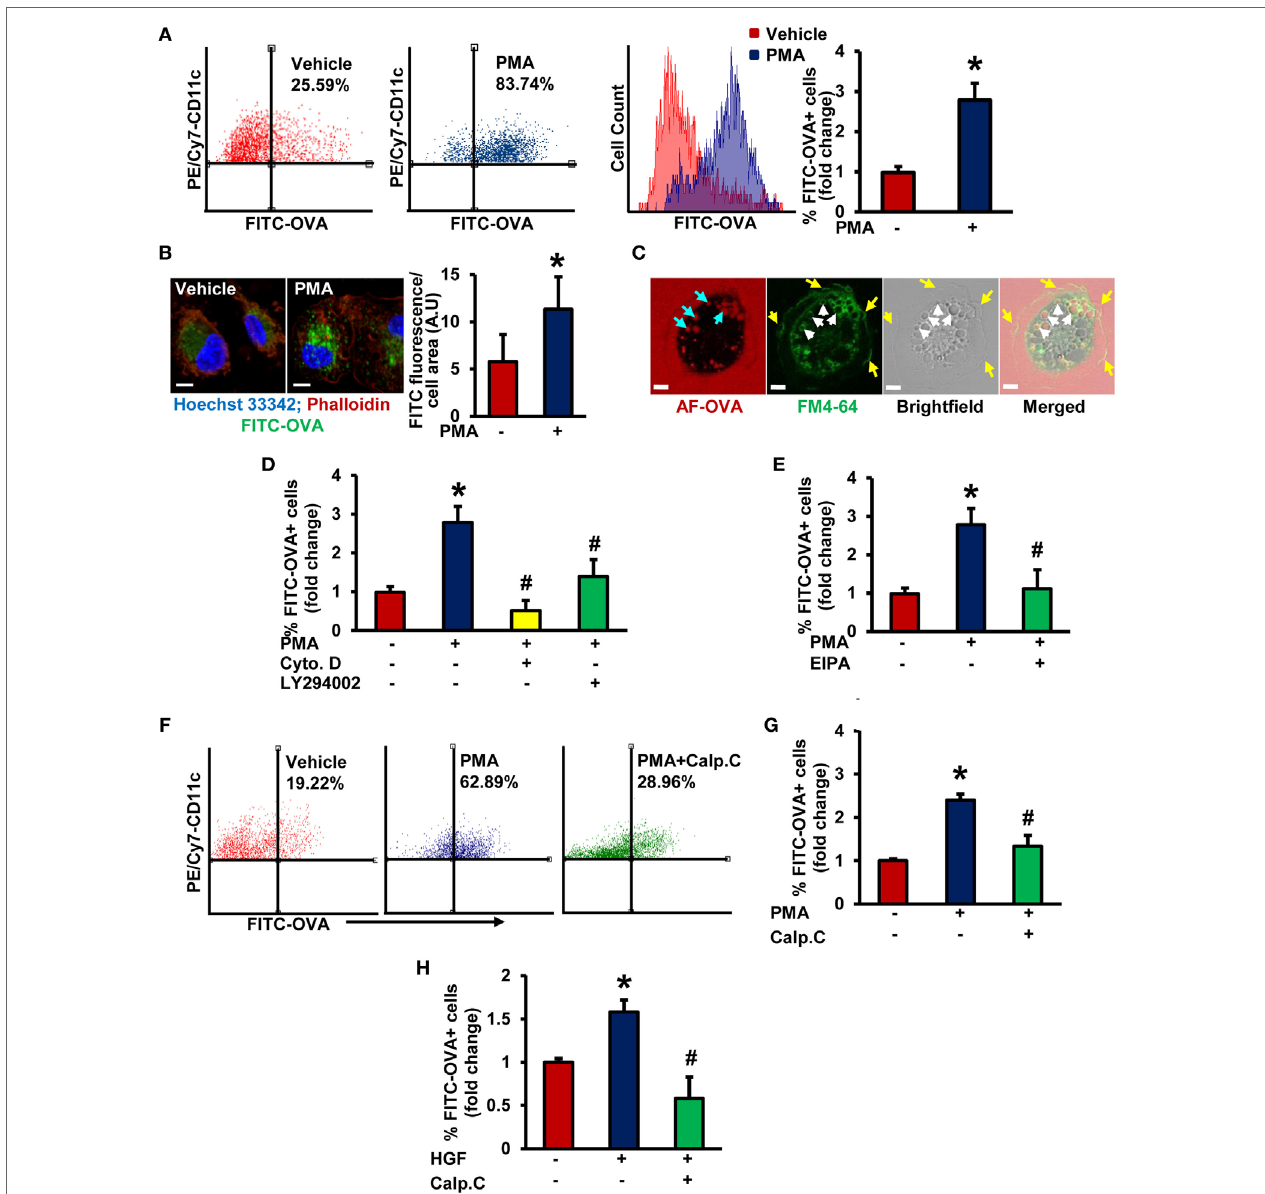
FigUre 1 | Protein kinase C activation promotes macropinocytosis of antigens in stimulated immature DCs (iDCs). (a) Wild-type (WT) bone marrow-derived immature dendritic cells (BMiDCs) were incubated with FITC-OVA (50 µg/mL; 45,000 MW) and treated with or without phorbol 12-myristate 13-acetate (PMA, 1 µM) for 5 h. Cells were stained with PE/Cy7-conjugated CD11c (or respective isotype control) monoclonal antibodies, fixed in 2% paraformaldehyde, and FITC fluorescence analyzed in PE/Cy7-gated CD11c + cells using a Becton Dickinson FACSCalibur flow cytometer. Gating strategy for flow cytometry analysis is shown in Figure S1 in Supplementary Material. Bar diagram shows the mean fold change in percentage of FITC fluorescence + cells among CD11c + population ( n = 7). (B) WT CD11c + BMiDC were incubated with FITC-OVA (50 µg/mL, green) and stimulated with vehicle or PMA (1 µM) for 5 h. Cells were fixed in 2% PFA, and stained with TRITC-phalloidin (red) and Hoechst 33342 (blue). Images were taken using a Zeiss 780 inverted confocal microscope (63 × ). Similar findings have been observed in three independent experiments. Scale bar: 5 µm. Bar diagram represents quantified mean FITC fluorescence normalized to cell area in vehicle- and PMA-treated cells. (c) WT CD11c + BMiDCs were treated with PMA (1 µM) for 30 min and incubated with the plasma membrane dye FM ™ 4-64 (green) and Alexa Fluor 488-OVA (AF-OVA, 50 µg/mL, red) for 10 min. Live cell imaging was performed using a Zeiss 780 inverted confocal microscope. Yellow arrows indicate membrane ruffles, white arrows indicate membrane-derived macropinosomes, and blue arrows point to internalized extracellular solutes in macropinosomes. Images are representative of three independent experiments. Scale bar: 5 µm. (D) WT BMiDC were preincubated with vehicle, cytochalasin D (Cyto. D, 1 µM, 30 min) or LY294002 (10 µM, 30 min), treated with PMA (1 µM), and incubated with FITC-OVA for 5 h. FITC-OVA uptake was analyzed by fluorescence-activated cell sorting (FACS) ( n = 3). (e) WT BMiDC were preincubated with vehicle or EIPA (25 µM) for 30 min, and challenged with PMA (1 µM, 5 h) in the presence of FITC-OVA. FITC-OVA internalization was analyzed by FACS ( n = 5). (F,g) WT BMiDC were preincubated with vehicle or calphostin C (Calp. C, 100 nM, 30 min), treated with PMA, and FACS was performed as described above ( n = 3). (h) WT BMiDC were preincubated with vehicle or calphostin C (Calp. C, 100 nM, 30 min), treated with HGF (100 ng/mL) in the presence of FITC-OVA for 5 h and FACS was performed to analyze FITC-OVA internalization. Bar diagram represents the mean fold change in FITC fluorescence + cells ( n = 3). Data represent the mean ± SD. * p < 0.05 vs. vehicle, # p < 0.05 vs.